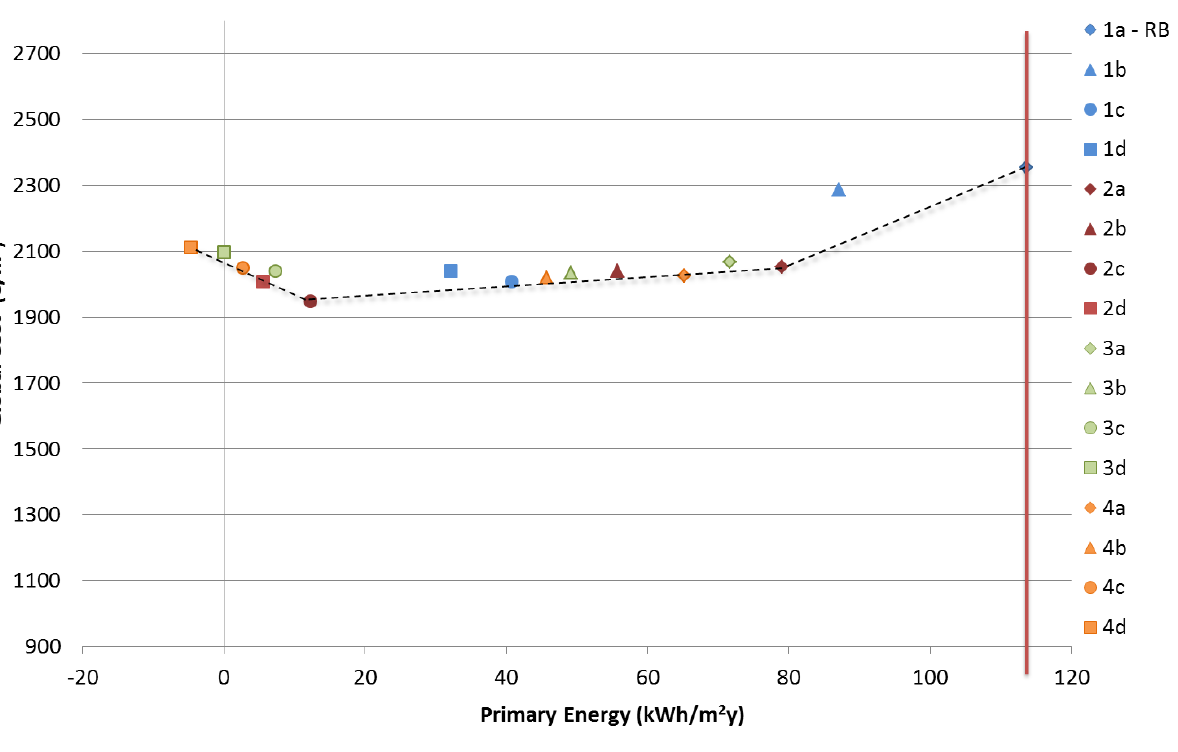
Figure 11. Cost-optimal